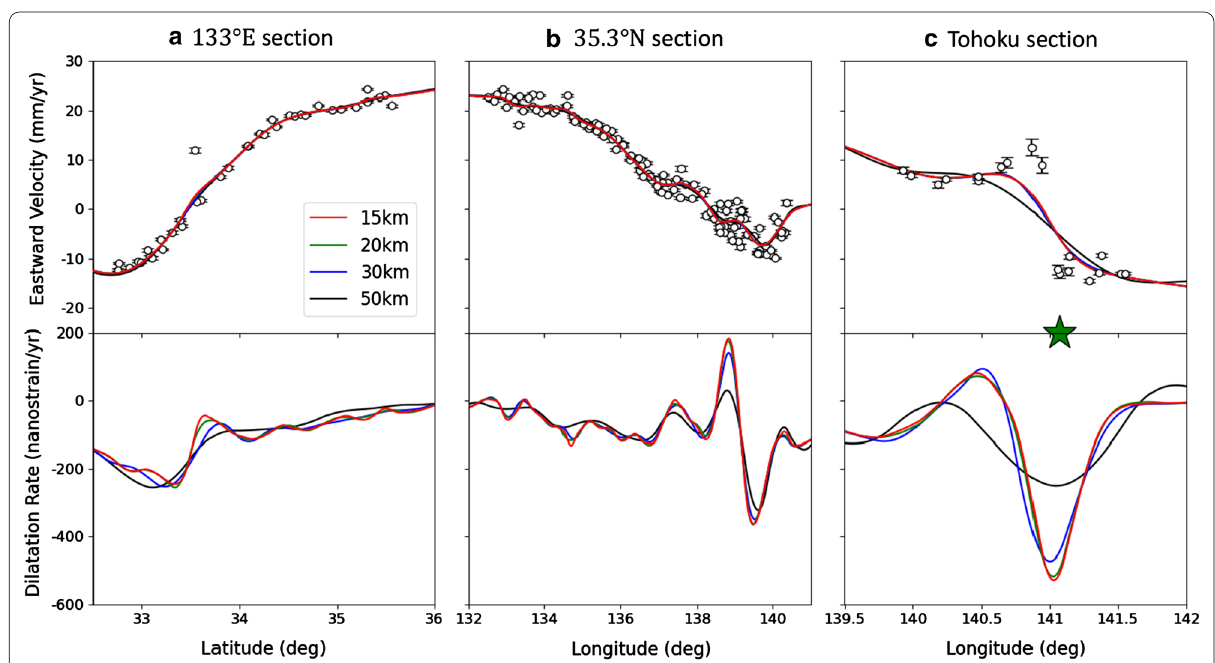
Fig. 9 Cross sections of the estimated eastward velocity and dilatation rates. Results of different values of the basis-function interval L are presented. The locations of the cross sections are the same as in Fig. 6; the location map is shown in Fig. 2. Observed velocity data within ± 0.2 ◦ longitude or latitude from the sections are also plotted. Error bars show the estimated uncertainty of velocity data at each site. The green star in c indicates the epicenter of the 2008 Iwate-Miyagi inland